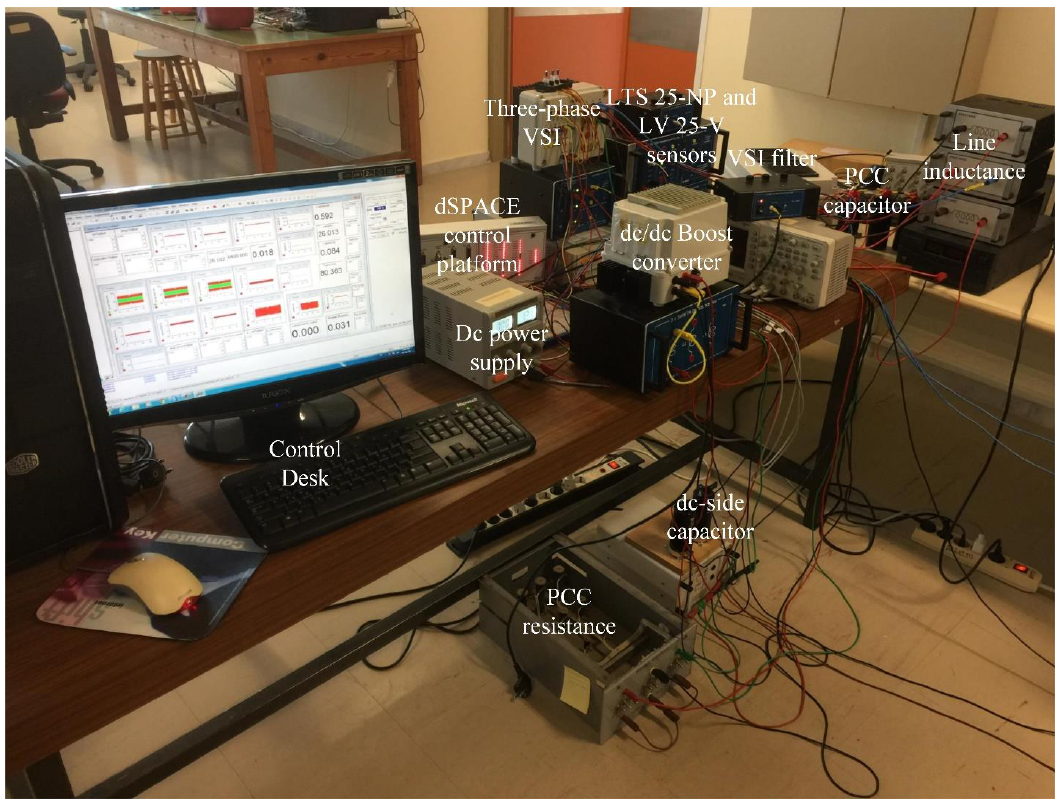
Figure 3. Experimental setup of the considered system.